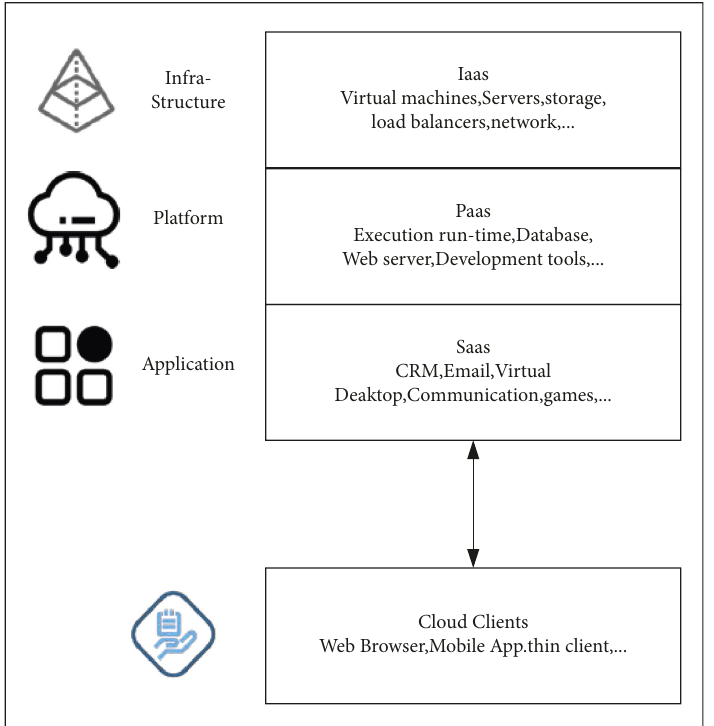
Figure 2: Layers of cloud computing.